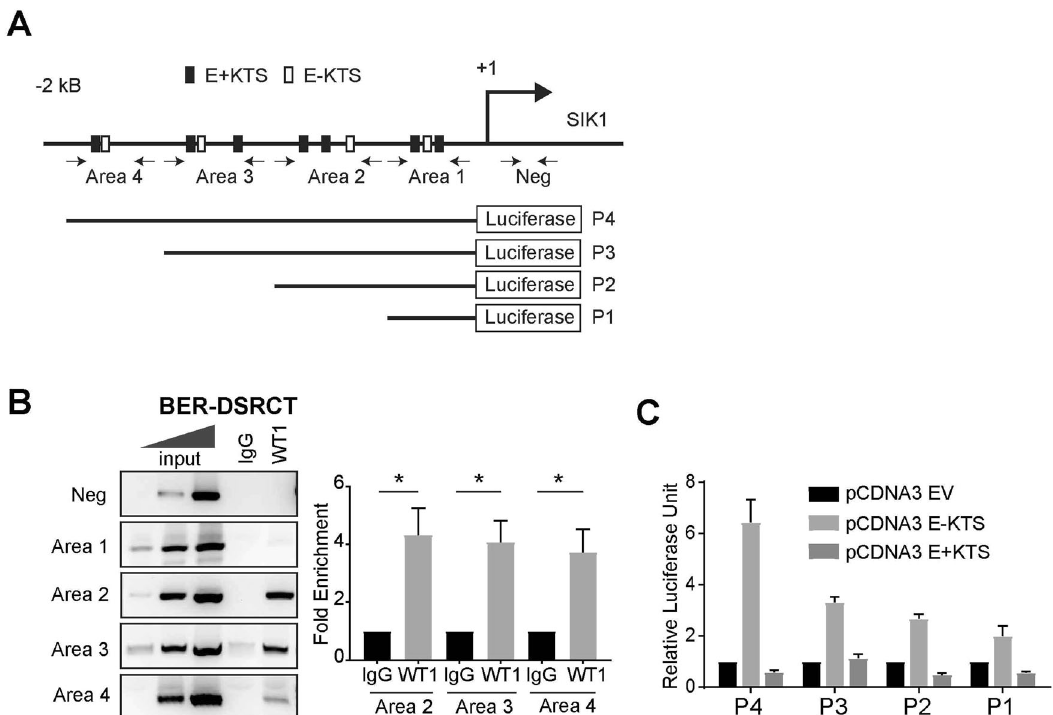
Fig. 2 EWSR1-WT1 directly activates SIK1 expression. A Schematic showing putative E-KTS and E + KTS binding sites in SIK1 2kB proximal promoter and P1-P4 luciferase reporter constructs. B ChIP analysis of SIK1 promoter with IgG or WT1 C-term antibody in BER-DSRCT cells. Areas 1 – 4 and negative regions were PCR-ampli fi ed with the indicated primers (arrows in C). Bands intensities were quanti fi ed using ImageJ and normalized to input ( n = 3, * p < 0.05, mean ± SEM, student t -test, lower panel). C EWSR1-WT1 directly activates SIK1 promoter. U2OS cells were transfected with pCDNA3-E-KTS, E + KTS or pCDNA3-Empty Vector and P1-P4 reporter constructs. Renilla Luciferase plasmid was used to normalize for transfection ef fi ciency. Relative luciferase activities were calculated relative to pCDNA3-empty vector from 4 independent experiments (mean ±